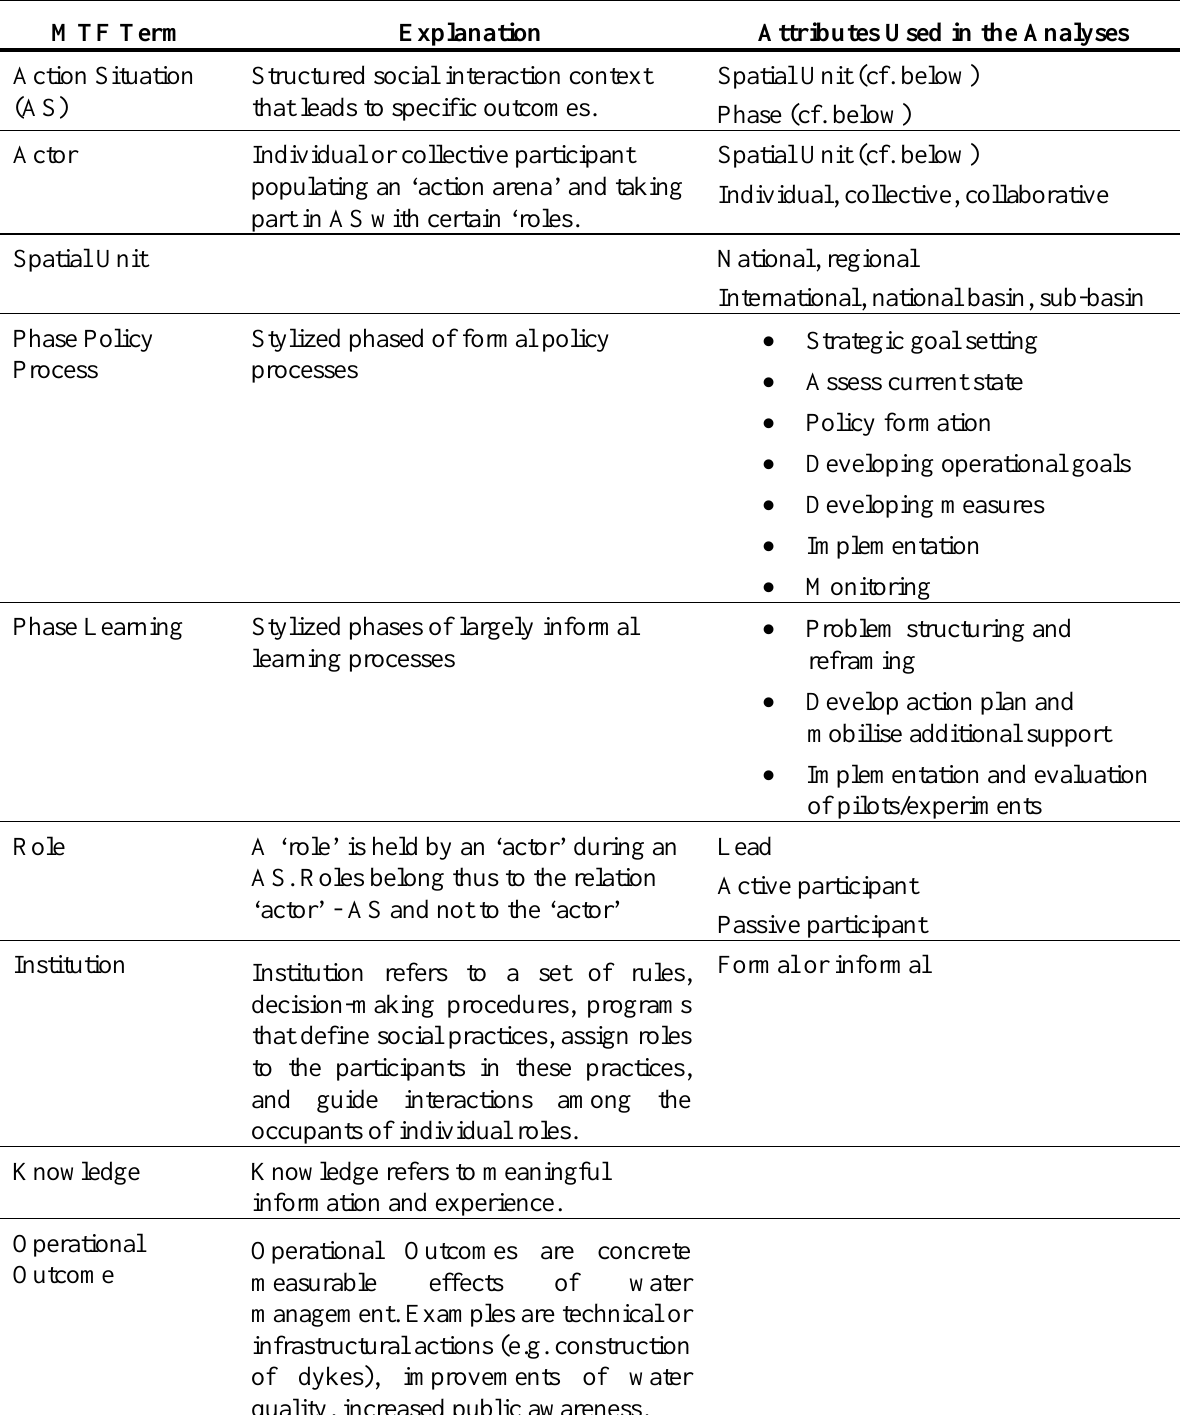
Table A1. Definition of terms used for the Management and Transition Framework (MTF) analyses in this paper (cf. Pahl-Wostl et al,